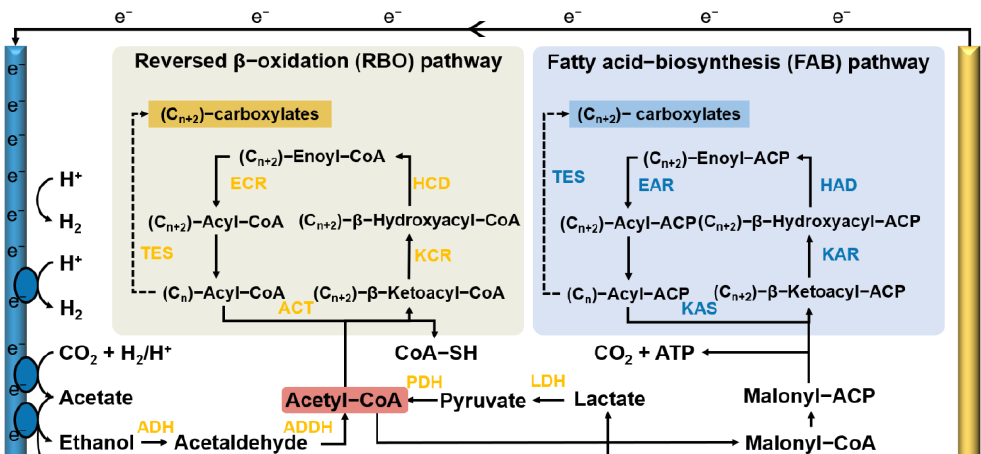
Figure 2. Schematic diagram of RBO and FAB pathways during chain elongation process in MCCAs electrofermentation. Abbreviation: CoA: coenzyme A; ACP: acyl carrier protein; LDH: lactic dehydrogenase; PDH: pyruvate dehydrogenase; ADH: alcohol dehydrogenase; ADDH: acetaldehyde dehydrogenase; ACT: Acetyl-CoA thiolase; KCR: ketoacyl-CoA reductase; HCD: hydroxyacyl-CoA dehydratase; ECR: enoyl-CoA reductase; TES: thioesterase; KAS: ketoacyl-ACP synthase; KAR: ketoacyl-ACP synthase; HAD: hydroxyacyl-ACP dehydratase; EAR: enoyl-ACP reductase [11,43,46].